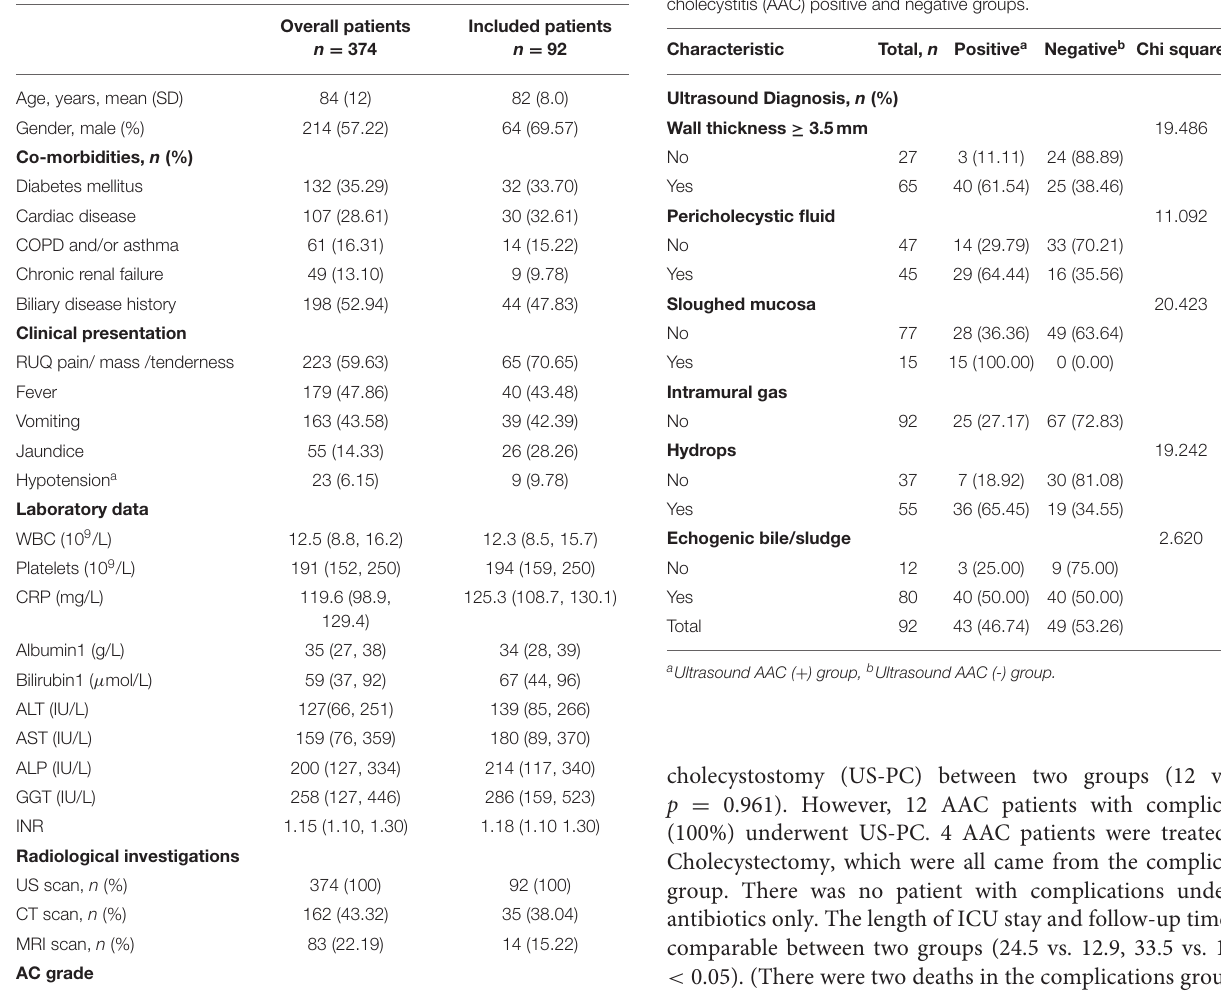
TABLE 1 | Patients’ demographic and clinical characteristics.